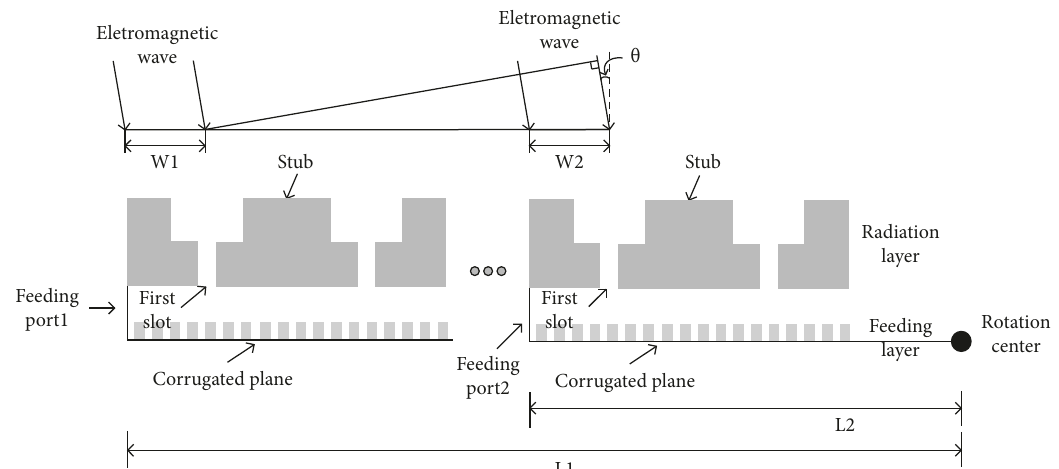
Figure 3: Phase difference between two VICTS subarrays on the same side of the rotation centre in the y